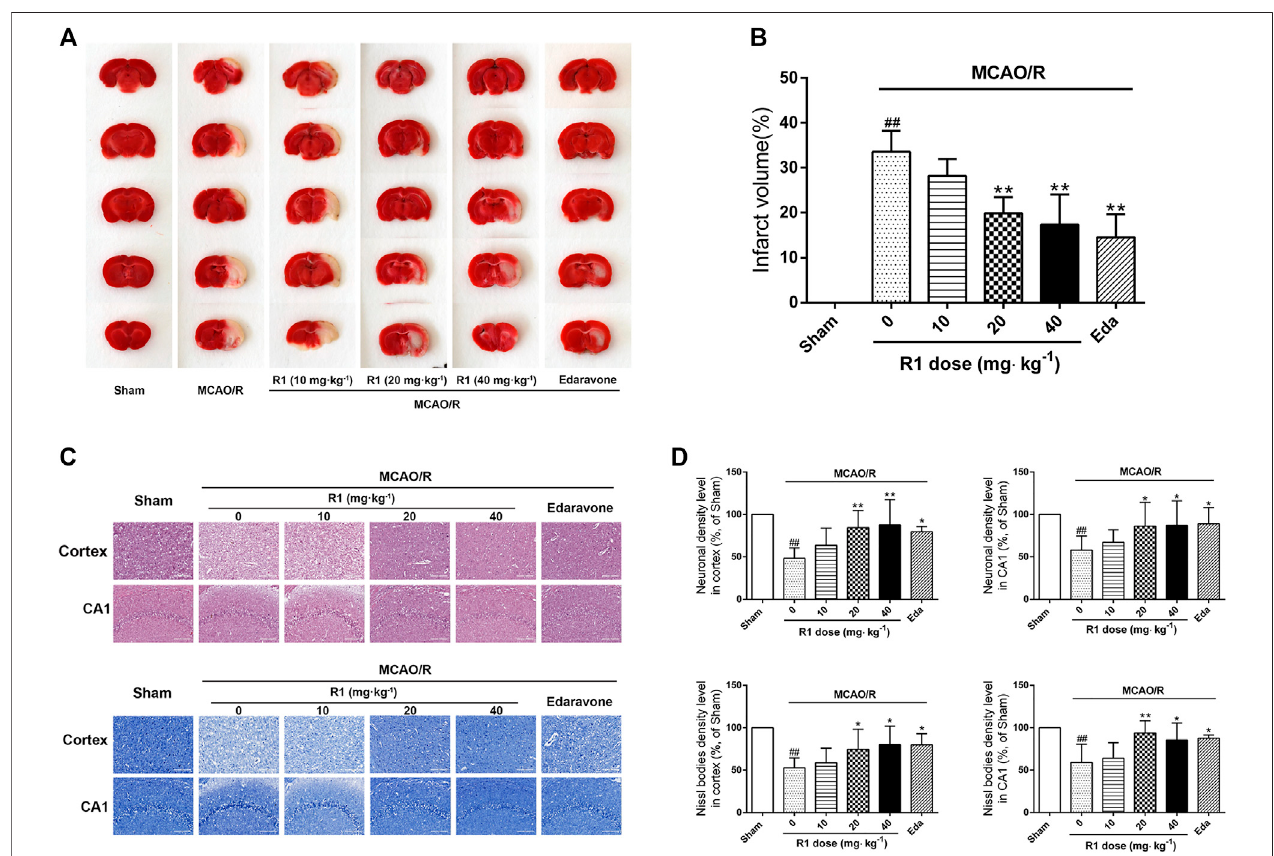
FIGURE2| R1reducestheinfarctionvolumeandneuronallossinratssubjectedtoMCAO.R1andedaravonewerebothintraperitoneallyinjectedimmediatelyafter MCAO surgery (A) Effects of R1 on infarction volumes (n (cid:1) 5) (B) Quantitative analysis of cerebral infarct volumes (C) H&E staining and Nissl staining of the cortex and hippocampal CA1 regions of each group ( n (cid:1) 5) (D) Relative density (% of sham) of the H&E and Nissl staining in the cortex and hippocampal CA1 regions in all the groups.Scalebar (cid:1) 200 μ m.Dataareexpressedasthemean ± SDandwereanalyzedbyANOVA. # p < 0.05and ## p < 0.01vs.Shamgroup;* p < 0.05and** p < 0.01 vs. MCAO/R